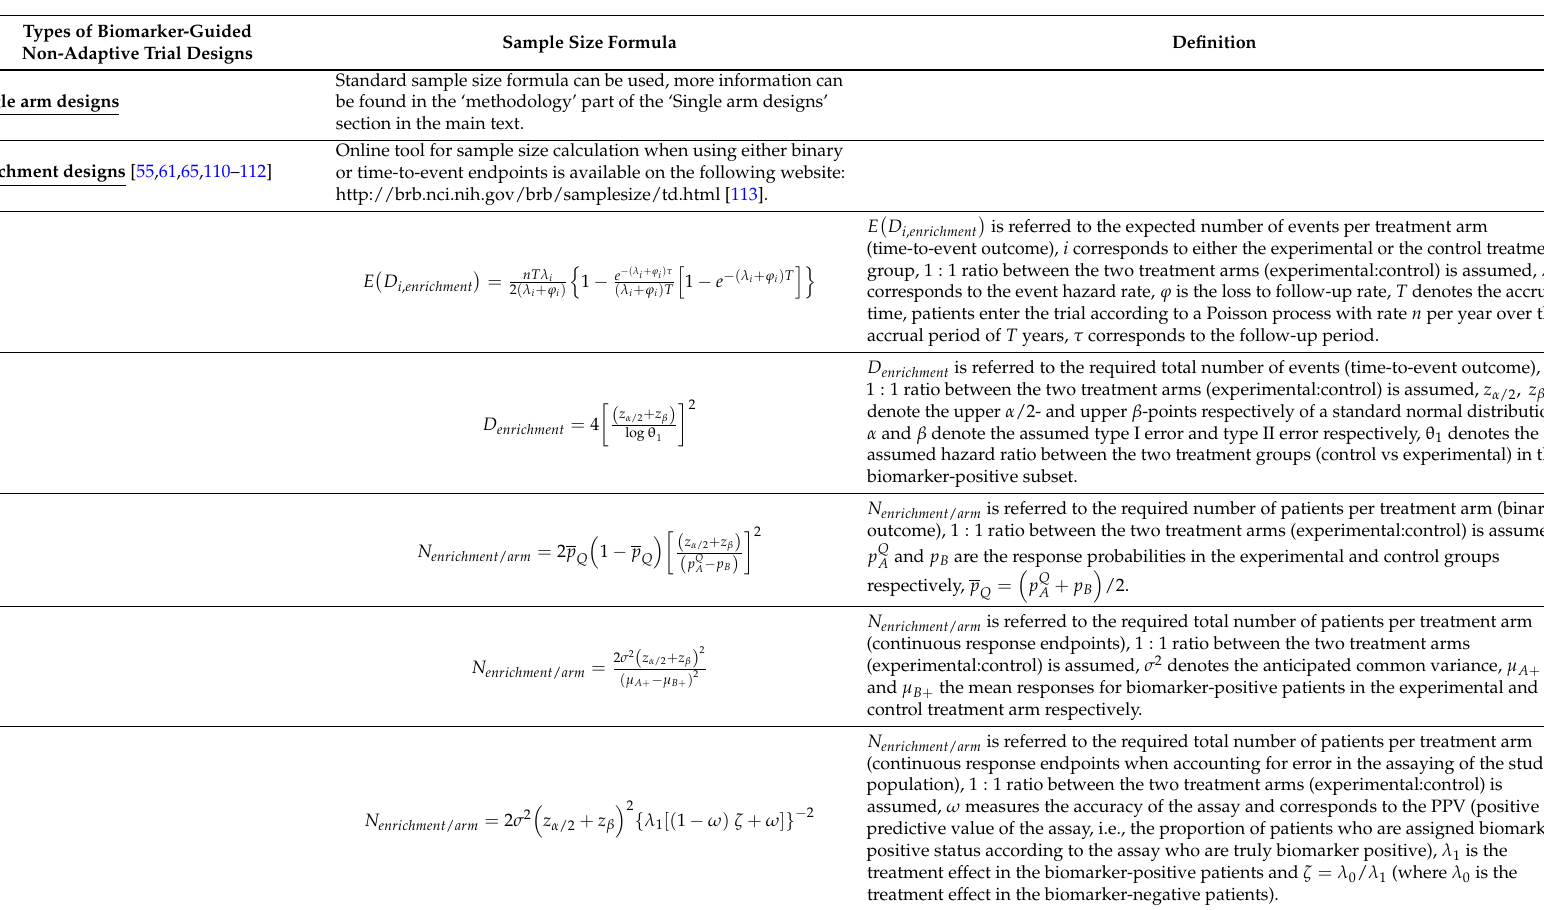
Table 2. Sample size formulae for biomarker-guided clinical trial